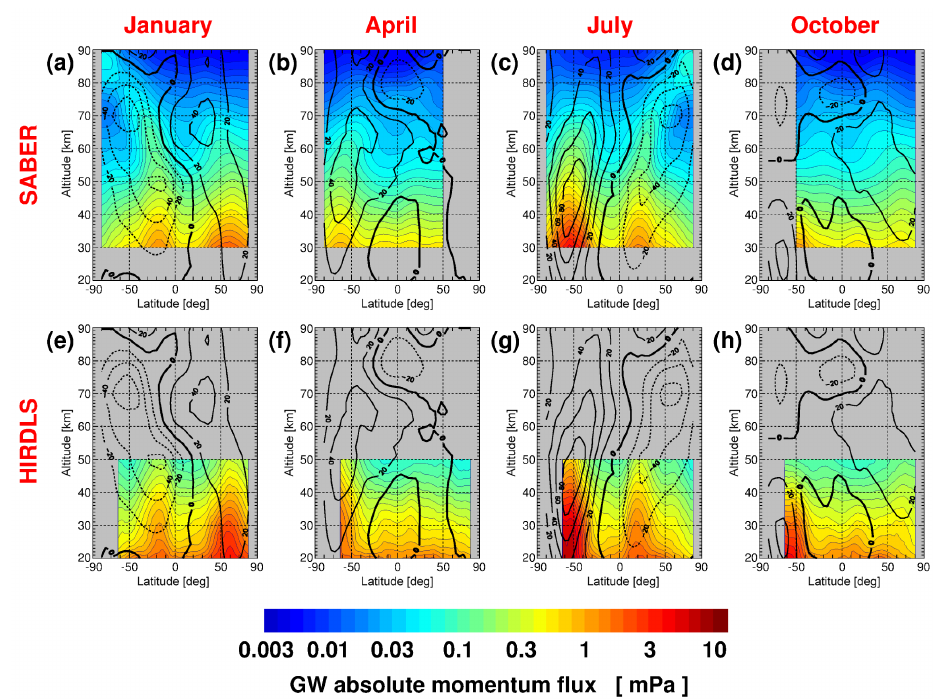
Figure 11. Latitude–altitude cross sections of zonal-average gravity wave absolute momentum fluxes in mPa. Shown are multi-year averages for SABER (a–d) and HIRDLS (e–h) for the months of January (a,e) , April (b,f) , July (c,g) , and October (d,h) . Overplotted winds are from the SPARC climatology (Swinbank and Ortland, 2003; Randel et al., 2002, 2004). Westward (eastward) winds are indicated by dashed (solid) contour lines. The zero wind line is bold solid. The contour line increment is 20ms − 1 .